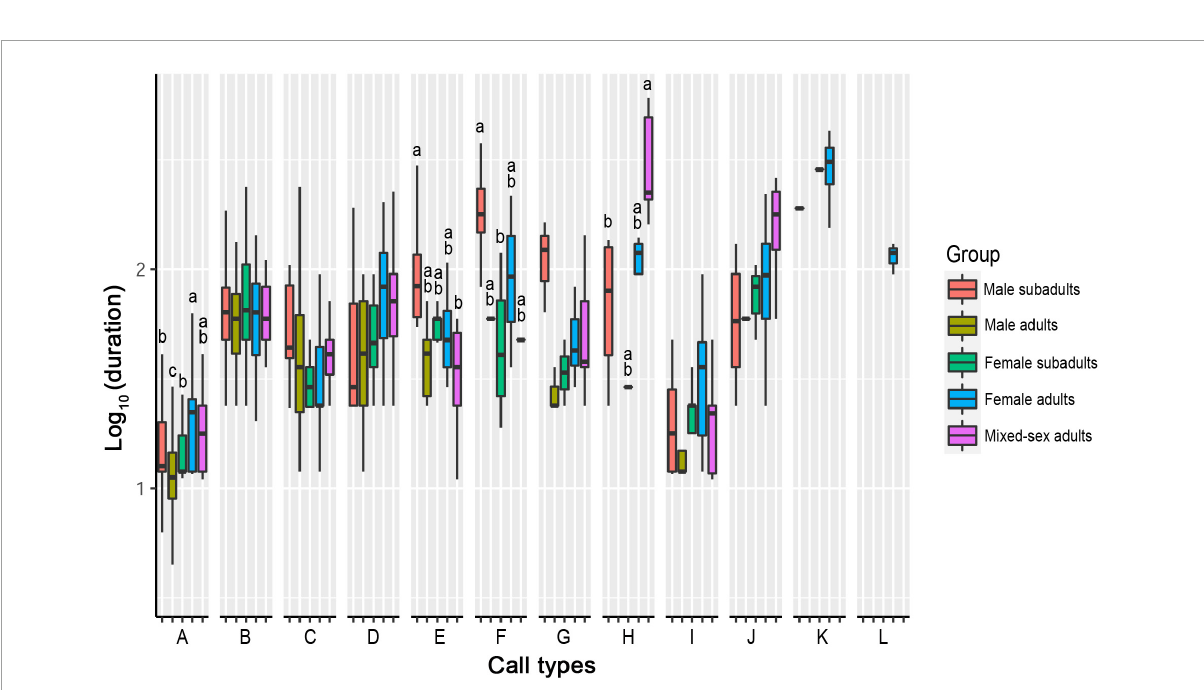
FIGURE6 Differences in call duration among five sex–age groups for all call types. The y -axis is the log-transformed value of duration. The x -axis represents the call types. Boxplots with different lowercase letters refer to Kruskal–Wallis comparison tests yielding significant results ( P < 0.05), and the relationship among the letters is a > b > c > d. Boxplots with the same lowercase letters did not differ significantly ( P > 0.05). Call types without letters on the boxplots showed no significant differences among sex–age